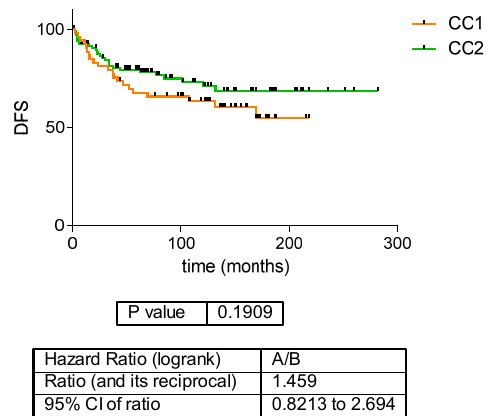
Figure 2. Disease-free survival in the two ccRCC proteomics subtypes.